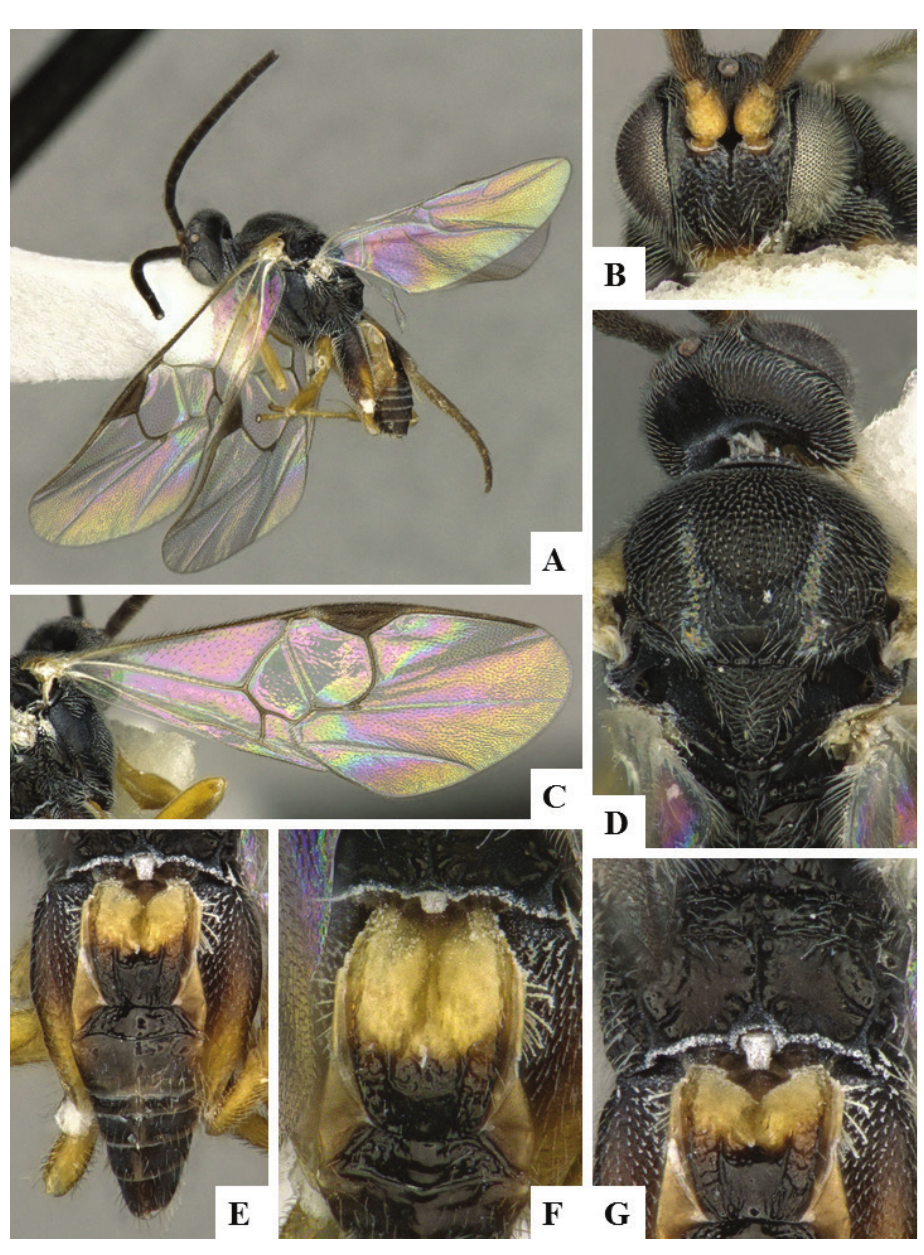
Figure 14. Janhalacaste danieli male holotype. A Habitus B Head frontal C Fore wing D Mesosoma dorsal E Metasoma dorsal F Tergites 1 to 2 G Propodeum.